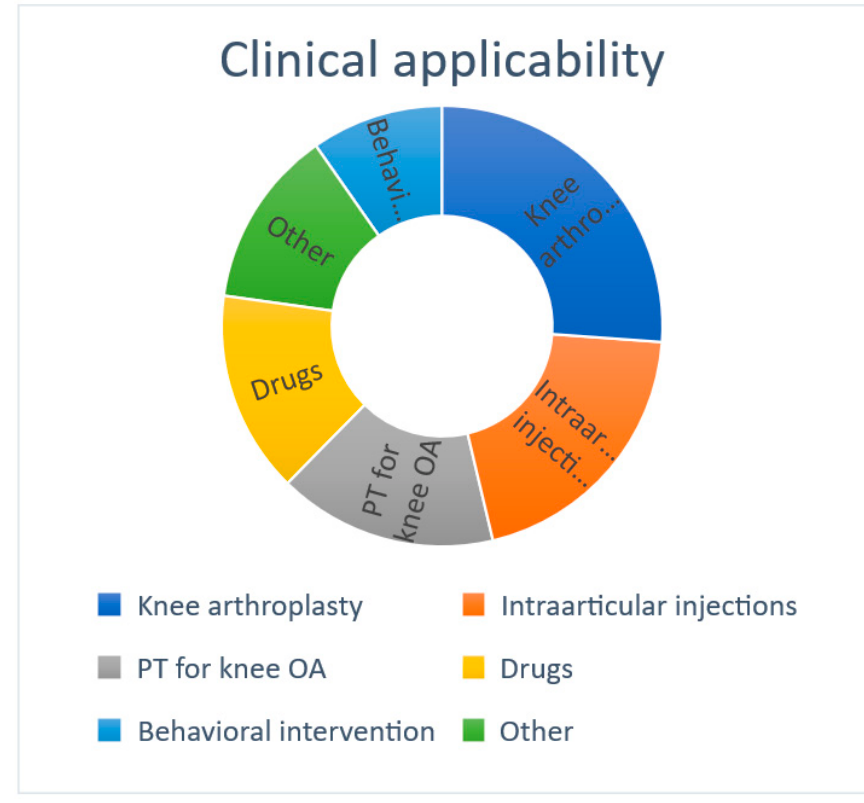
Figure 6. Clinical applicability distribution.